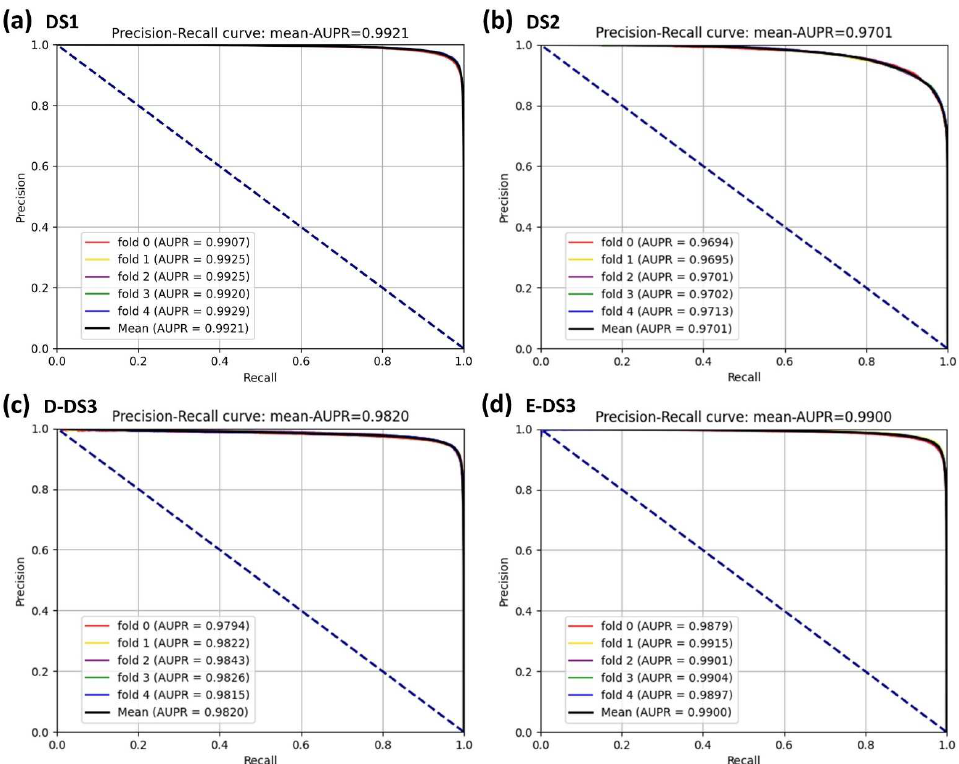
Figure 6. PR curves of the five-fold cross-validation on the four datasets by the proposed method,